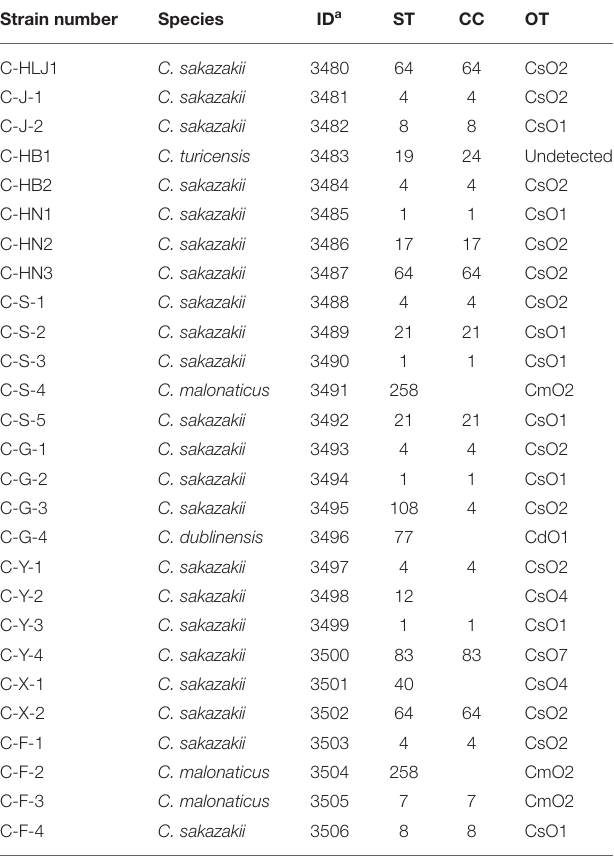
TABLE 2 | MLST and O-antigen serotyping of 27 Cronobacter isolates. Strain